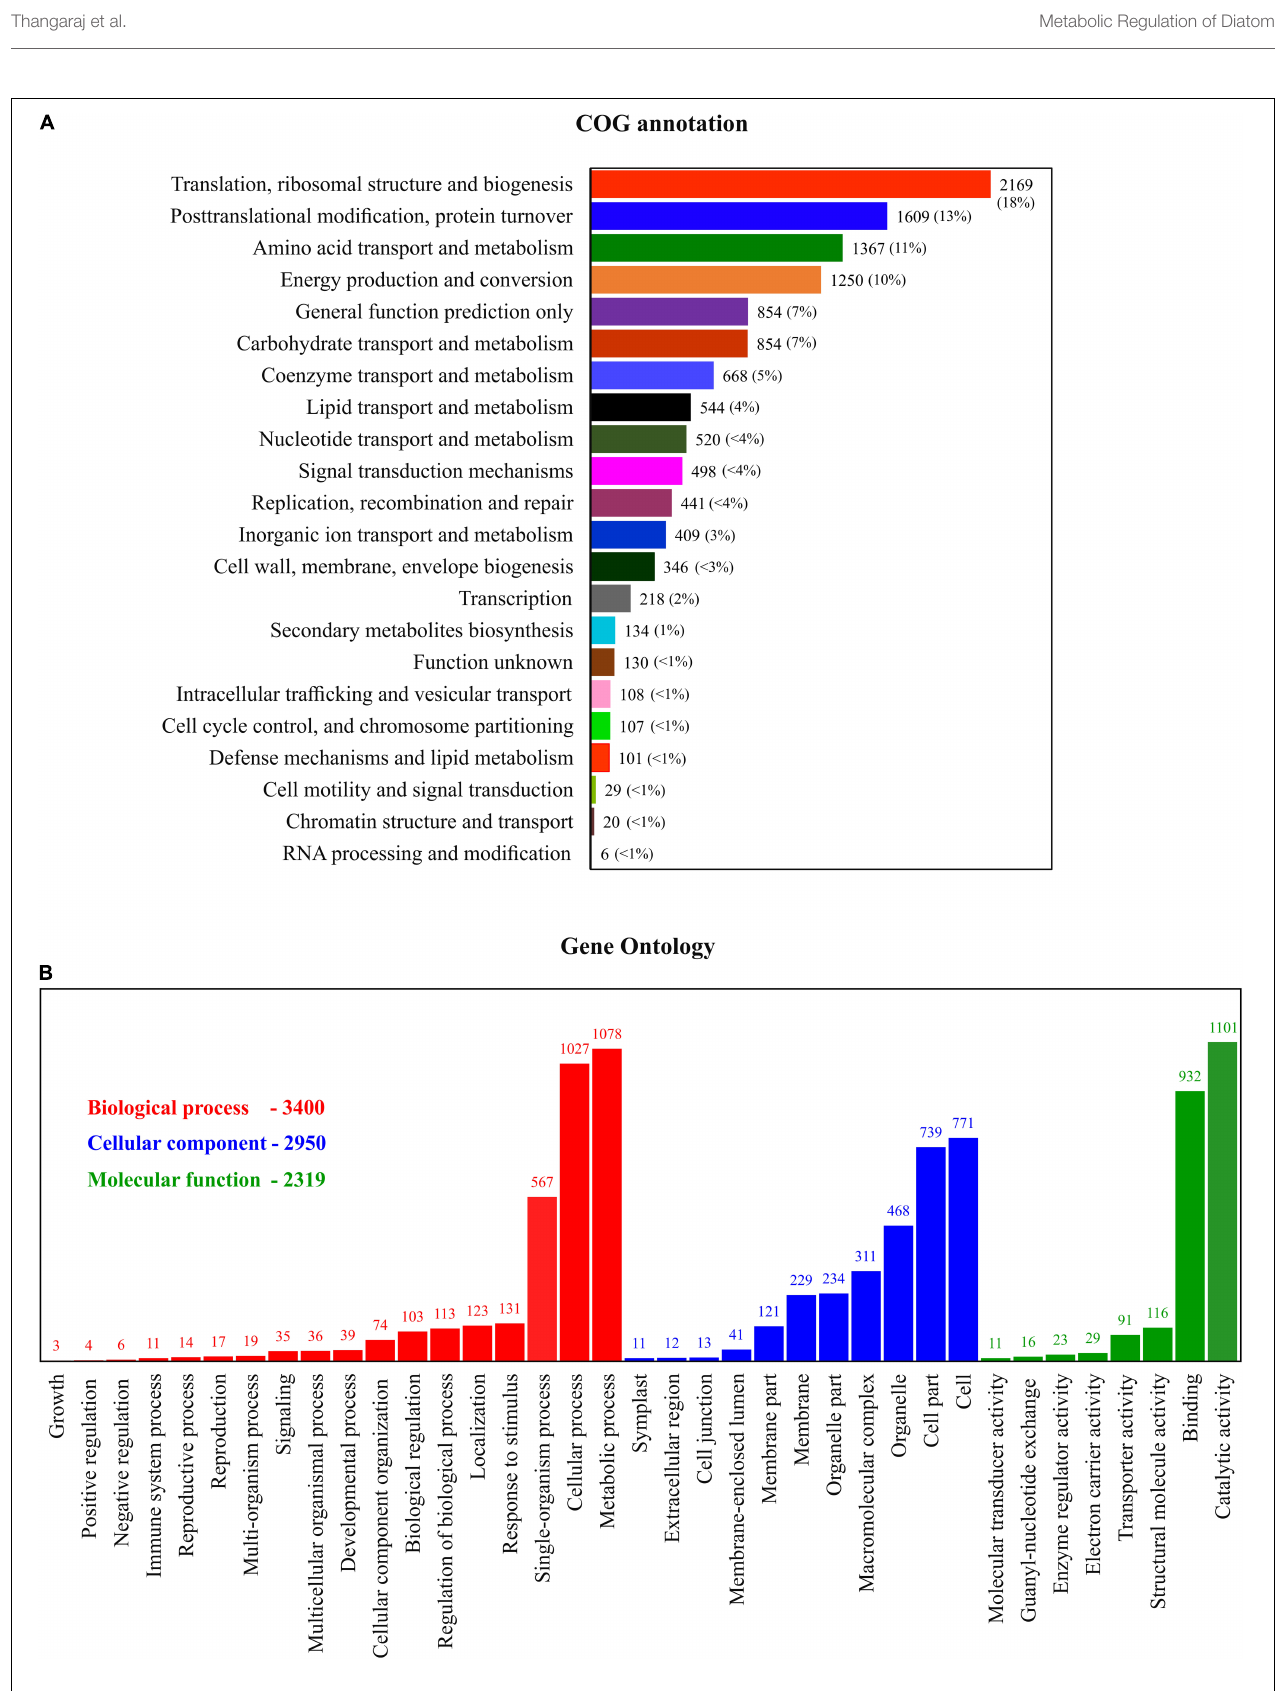
FIGURE 4 | Functional annotation of the COG (A) and GO (B) analysis of the proteins identified in this study.